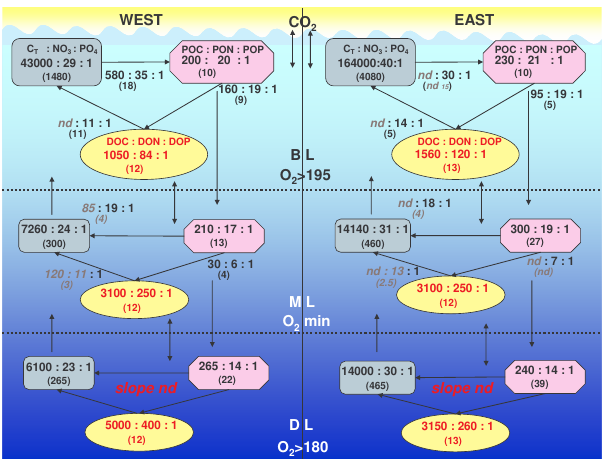
Fig. 9. Representation of the elemental C:N:P stoichiometry in Figure 9. Representation of the elemental C:N:P stoichiometry in terms of stocks and fluxes for the 20 terms of stocks and fluxes for the western (left) and eastern (right) western (left) and eastern (right) basins of the Mediterranean Sea. The water column is divided in 21 basins of the Mediterranean Sea. The water column is divided in BL, ML and DL as justified in Fig. 2. The blue rectangular boxes with smooth corners symbolize 22 BL, ML and DL as justified in Fig. 2. The blue rectangular boxes the mineral compartment, the pink rectangular boxes with sharp corners symbolize the POM, 23 with smooth corners symbolize the mineral compartment, the pink whereas the yellow circles symbolize the DOM. In each box, the indicated ratios correspond to 24 rectangular boxes with sharp corners symbolize the POM, whereas the average concentration ratios over the layer for C:P, and N:P. The values in brackets 25 the yellow circles symbolize the DOM. In each box, the indicated correspond to the average C:N ratio. On arrows, indicated ratios correspond to the slope of the 26 ratios correspond to the average concentration ratios over the layer linear regression equations between C:P, and N:P respectively. The values in brackets correspond 27 for C:P, and N:P. The values in brackets correspond to the average to the slope of the C:N plot regression. (nd) is for non significant linear relationship ( α = 0.05). 28 C:N ratio. On arrows, indicated ratios correspond to the slope of the linear regression equations between C:P, and N:P, respectively. The values in brackets correspond to the slope of the C:N plot re- gression. (nd) is for non significant linear relationship ( α = 0 .